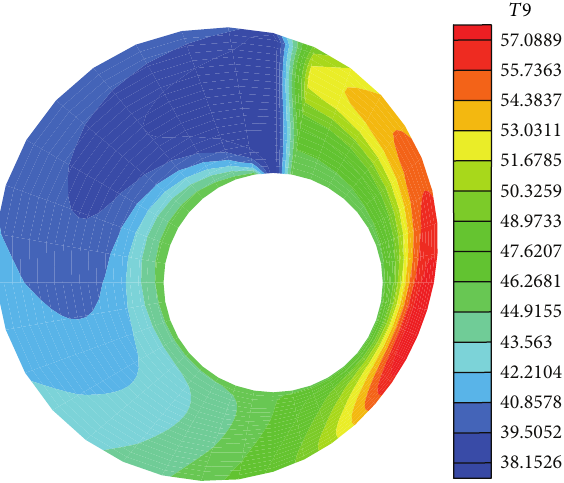
Figure 9: Isothermal lines of the journal bearing at its central plan for 𝑁 = 3000 rev./min and 𝑛 = 1.1 .